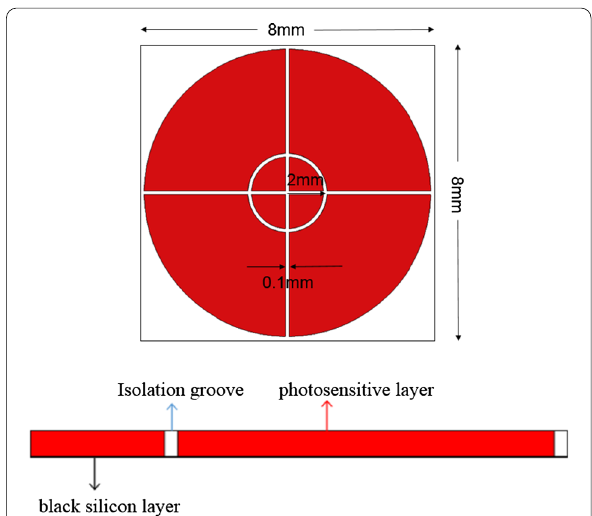
Fig. 1 The schematic structure of dual four-quadrant